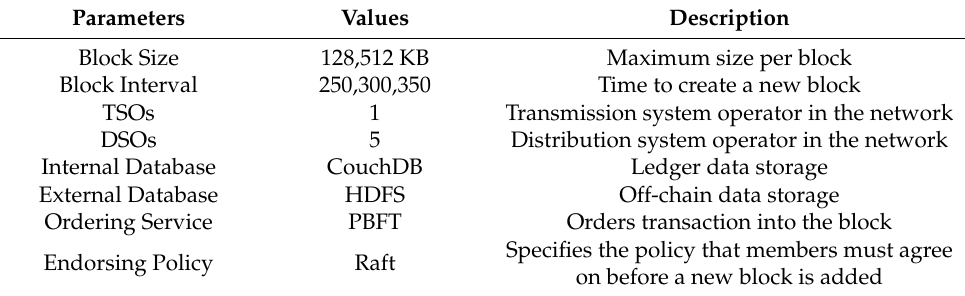
Table 4. Experimental setup parameters for a blockchain